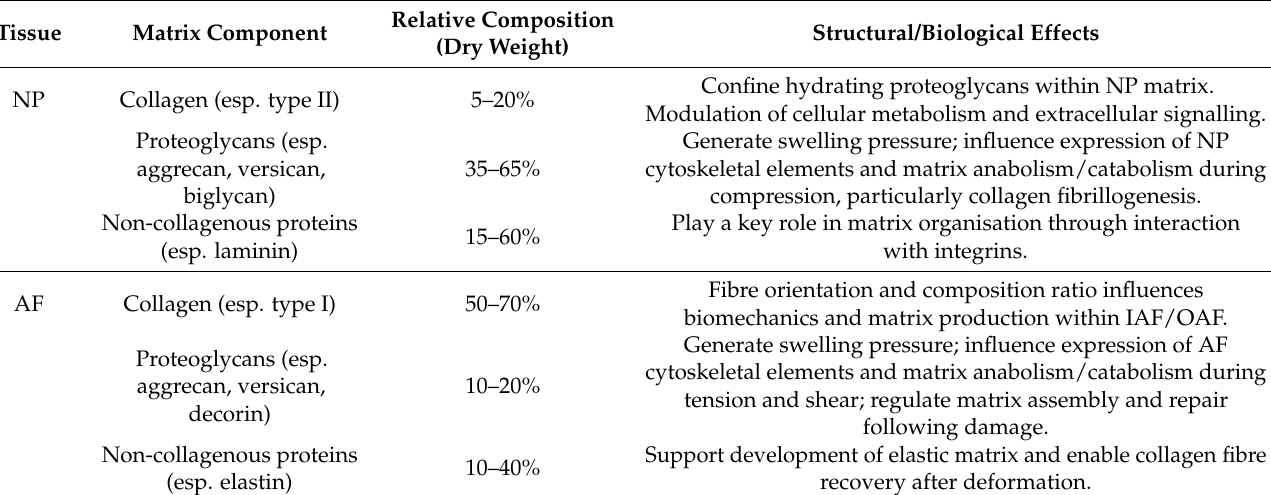
Table 1. Composition and biological function of key matrix components within healthy adult IVDs